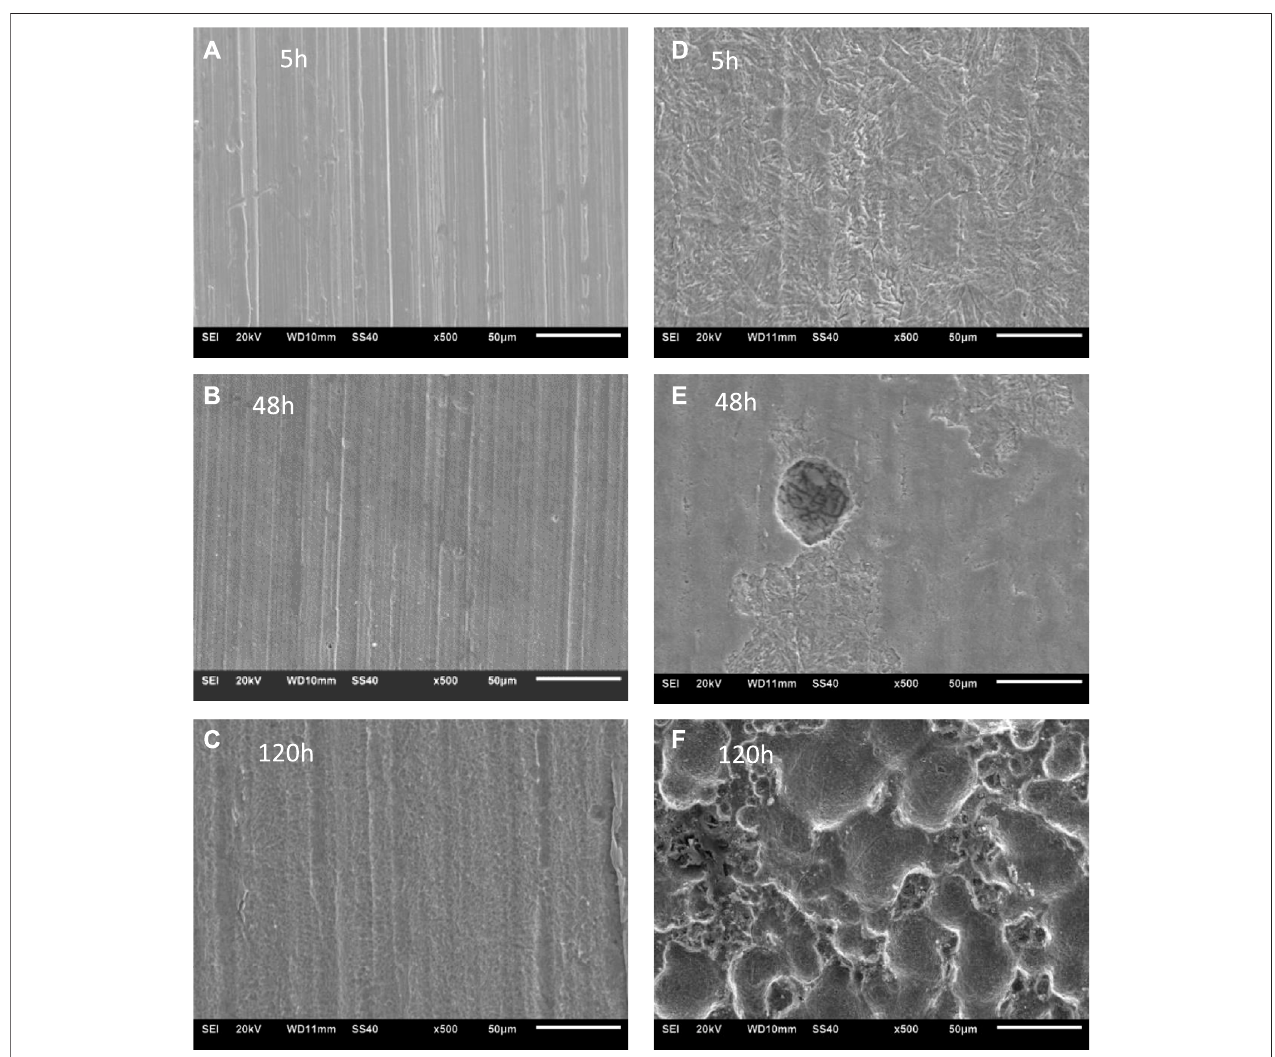
FIGURE 8 | SEM images of corroded S13Cr SS samples exposed under the 180 ° C formate condition with (A – C) N 2 and (D – F) CO 2 saturated after removing the corrosion products.